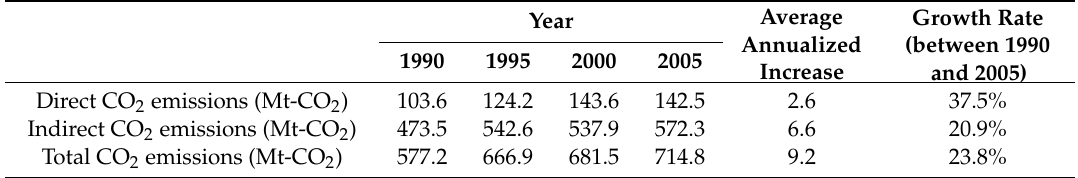
Table 1. Compositions of Japanese household carbon footprints (CF) in